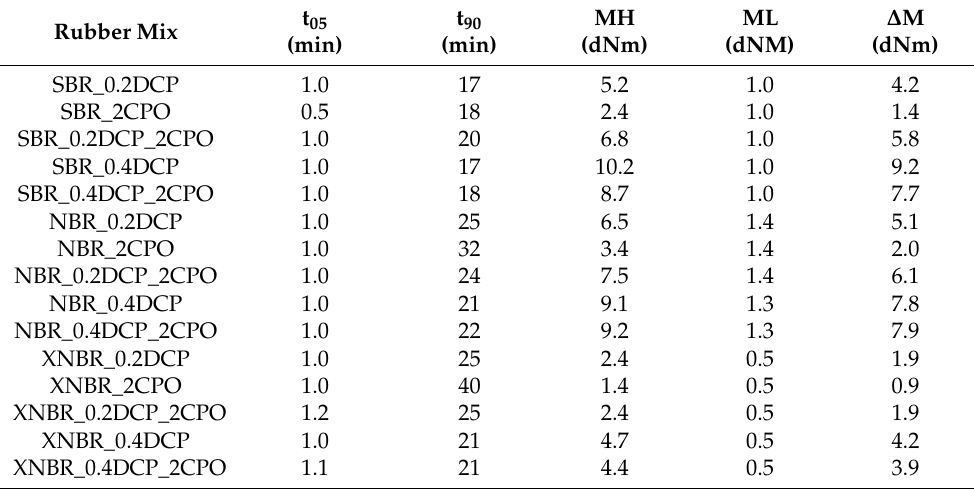
Table 2. Curing parameters of the rubber compounds studied.